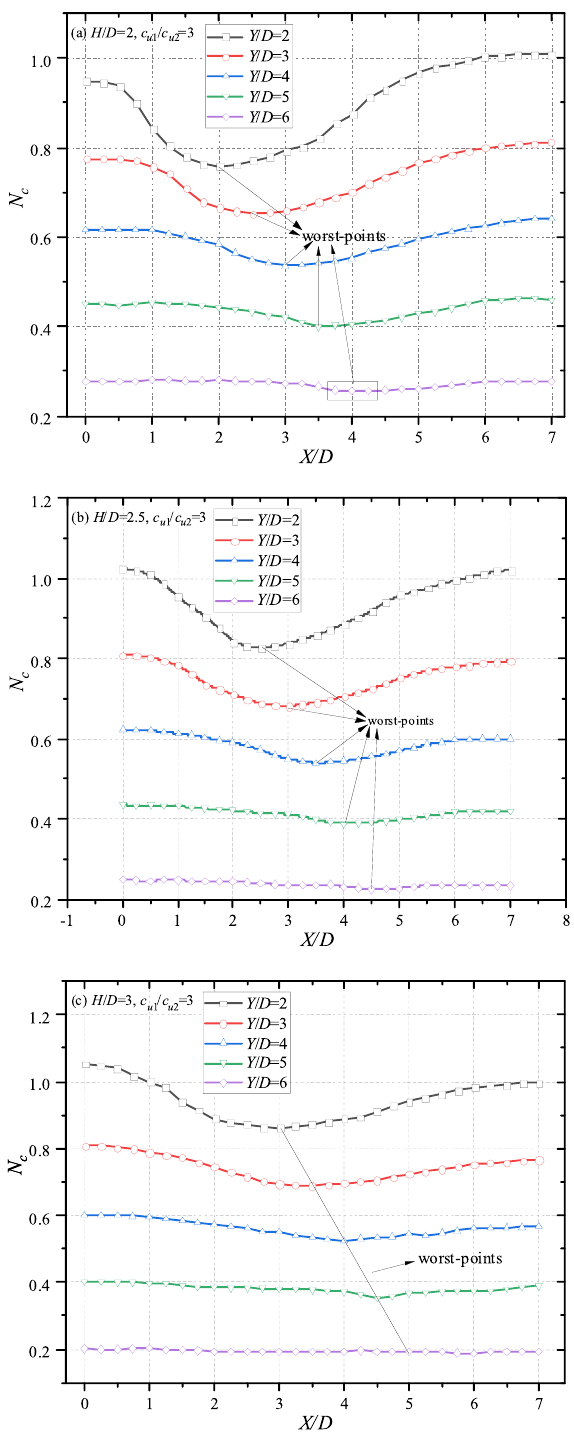
Figure 9. Variation of N c with different X / D and Y / D for ( a ) H / D = 2, c u1 / c u2 = 3; ( b ) H / D = 2.5, c u1 / c u2 = 3; ( c ) H / D = 3,